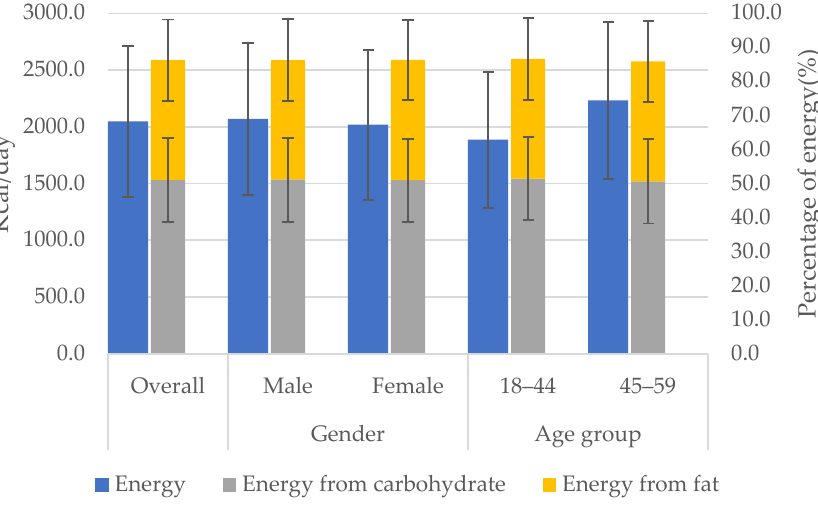
Figure 2. Energy intake and percentage from carbohydrate and fat by gender and age group. Table 2. The effects of distress and coping factors on energy intake by